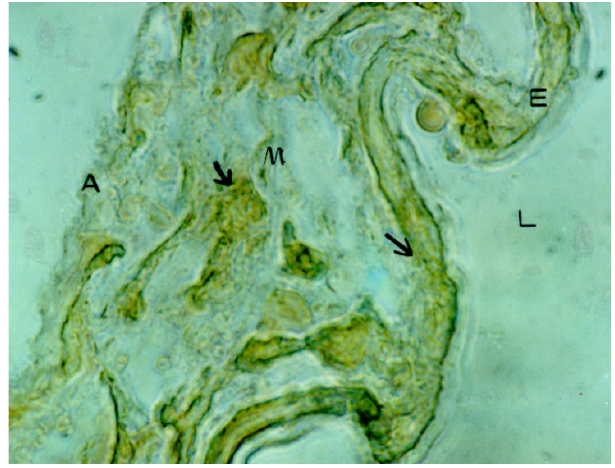
Figure 3 Aorta of a high cholesterol diet animal (400 × ). Arrows indicate cholesterol deposits in the endothelium layer and media tunica region.